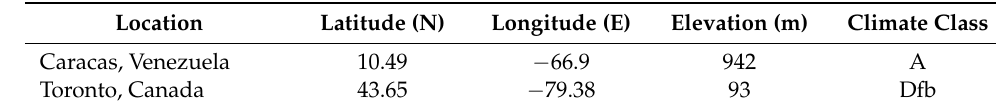
Table 3. External datasets source information.